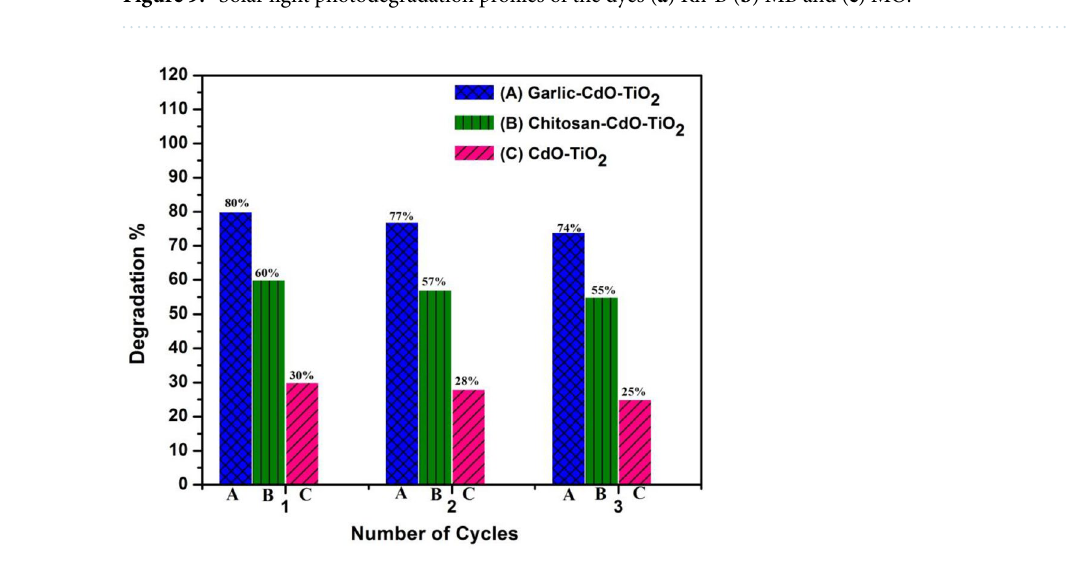
Figure 9. Solar light photodegradation profiles of the dyes ( a ) Rh-B ( b ) MB and ( c ) MO.